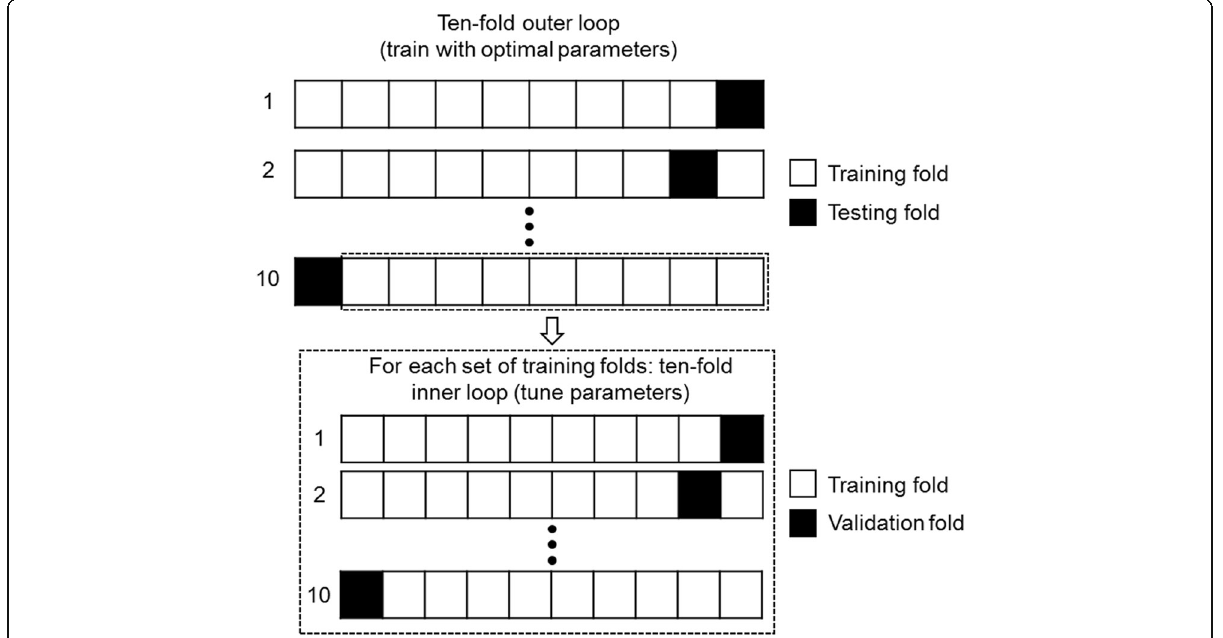
Fig. 1 Schematic overview of the tenfold cross-validation. Within each tenfold of the outer loop for training and testing, a tenfold cross-validation inner loop was defined over the training folds to optimize classifier-specific